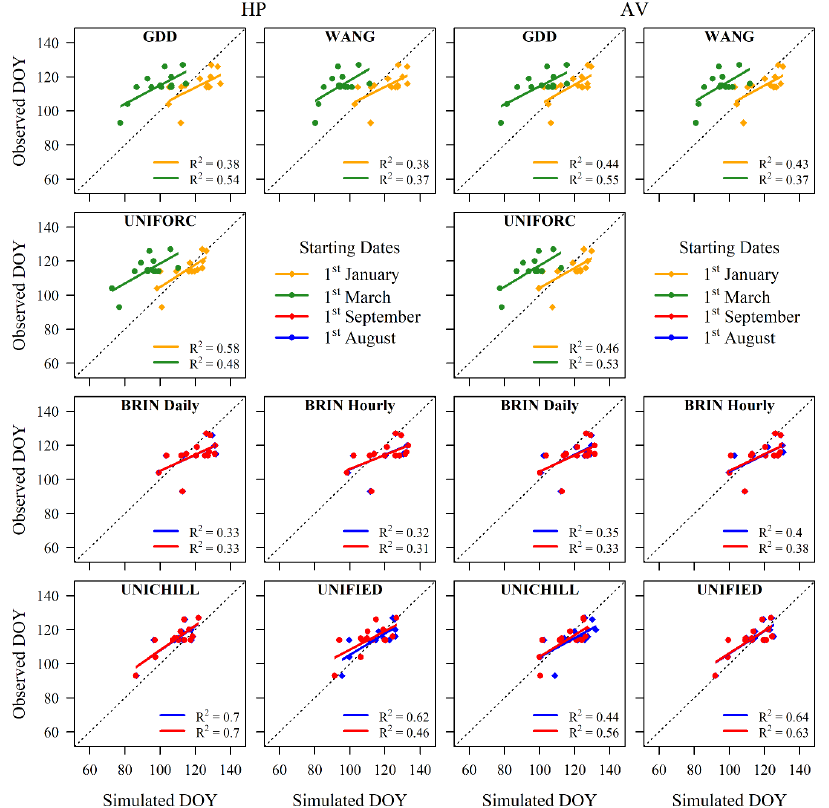
Figure 5. Highest-p erformance (HP) and average (AV) parameters’ set applied on the independent datasets by considering all phenological models and starting dates. The example of Chardonnay